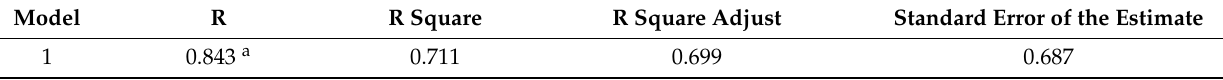
Table 18. Method